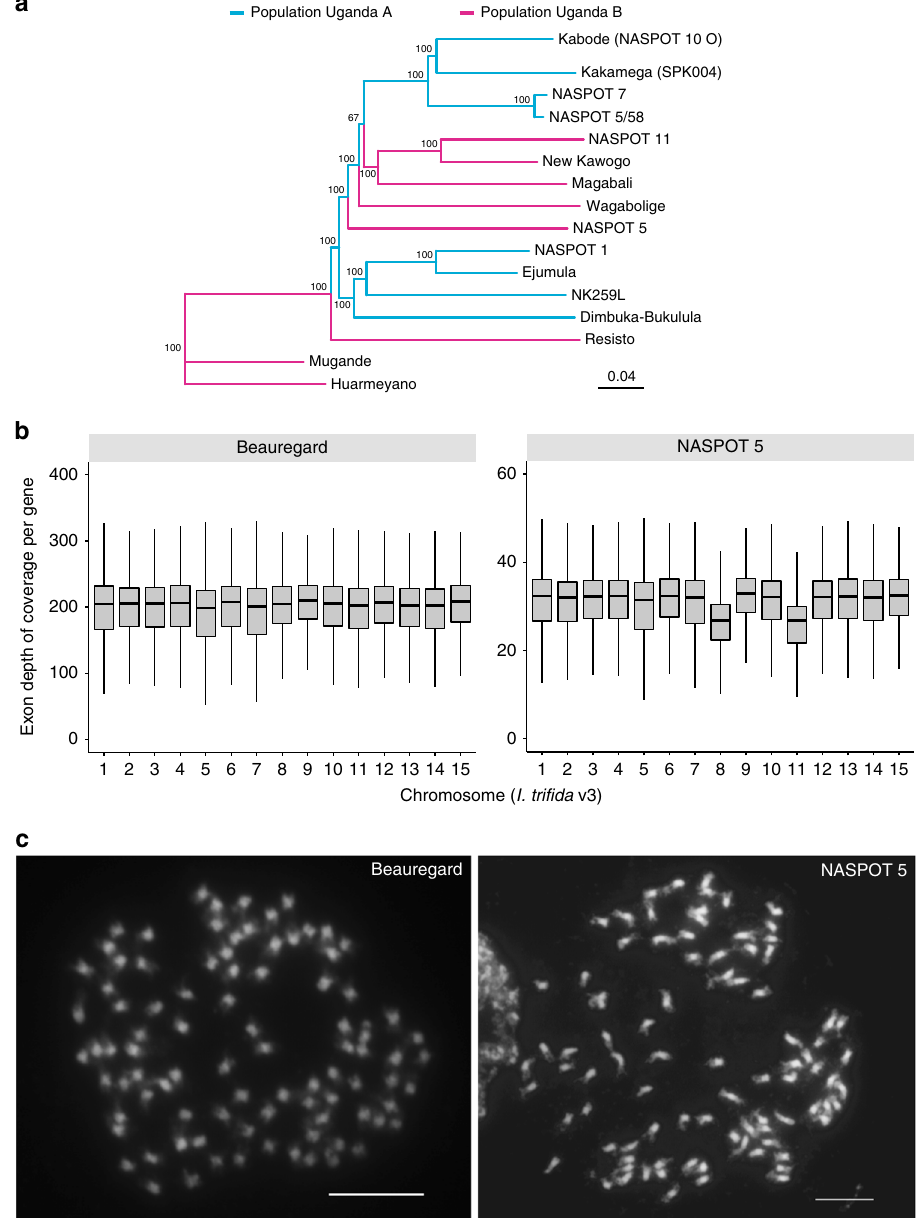
Fig. 4 Genetic diversity of key African sweetpotato accessions. a Neighbor-joining phylogenetic tree of the Mwanga Diversity Panel accessions based on single nucleotide polymorphisms detected using the I. tri fi da genome as the reference. Population membership based on previous simple sequence repeat analysis is indicated by branch colors. Numbers at nodes indicate the percentage of 1000 bootstrap replications that support each clade. Huarmeyano was used as an outgroup for rooting. b Read depth analyses of “ Beauregard ” and “ NASPOT 5 ” based on alignment to the I. tri fi da genome. For each box plot, the lower and upper bounds of the box indicate the fi rst and third quartiles, respectively, and the center line indicates the median. c A metaphase cell of “ Beauregard ” showing 90 chromosomes and “ NASPOT 5 ” showing 88 chromosomes. Bars represent 10 μ